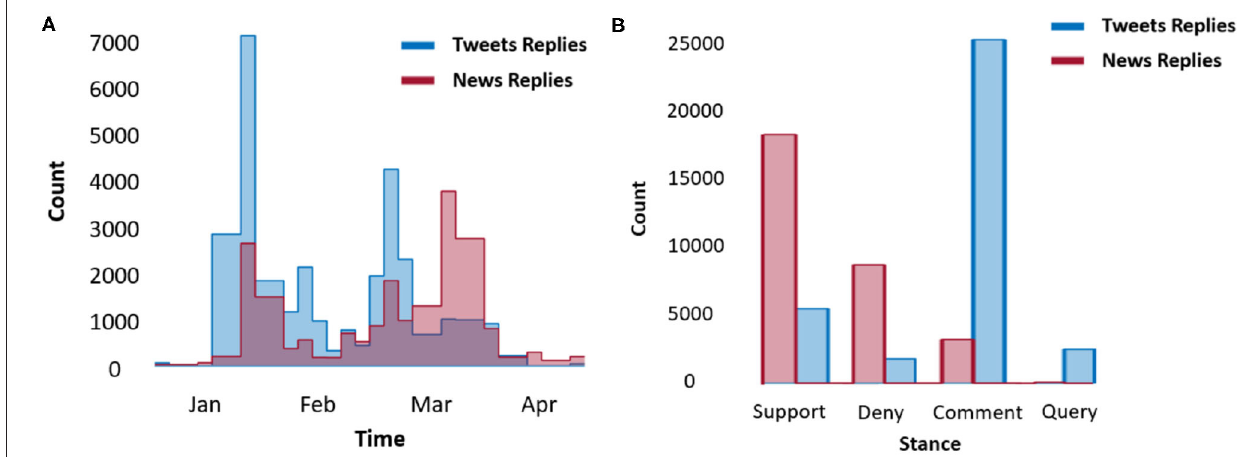
FIGURE 3 | Reply records (A) and their stance statistics (B) in the collected COVID-19